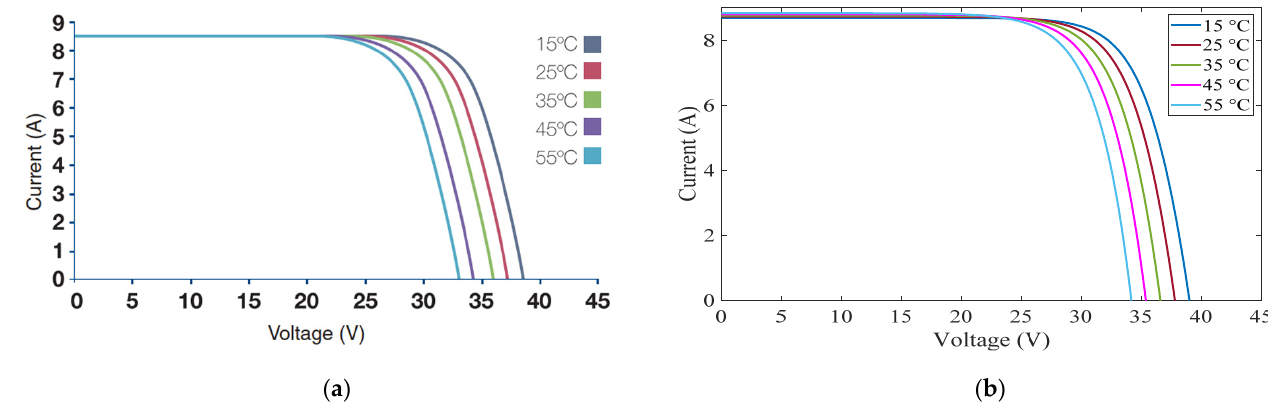
Figure 8. Characteristic of the power curves of the monocrystalline module ISF-250. ( a ) Manufacturer curves [40], ( b ) Curves obtained with the algorithm. Table 6. Error rate between actual and estimated electrical characteristics.